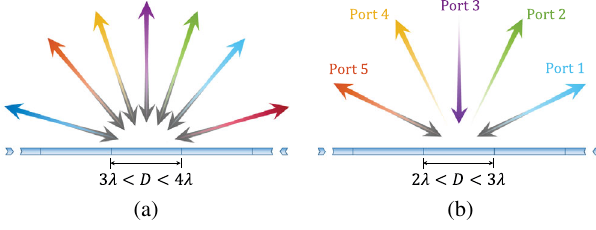
FIG. 13. (a) N -port isolating mirror. The wave impinging from different angles (grey arrows) is reflected back to the source (colored arrows). (b) Multifunctional reflector. Normally incident light is split between ports 2 and 4. Ports 1 and 5 are